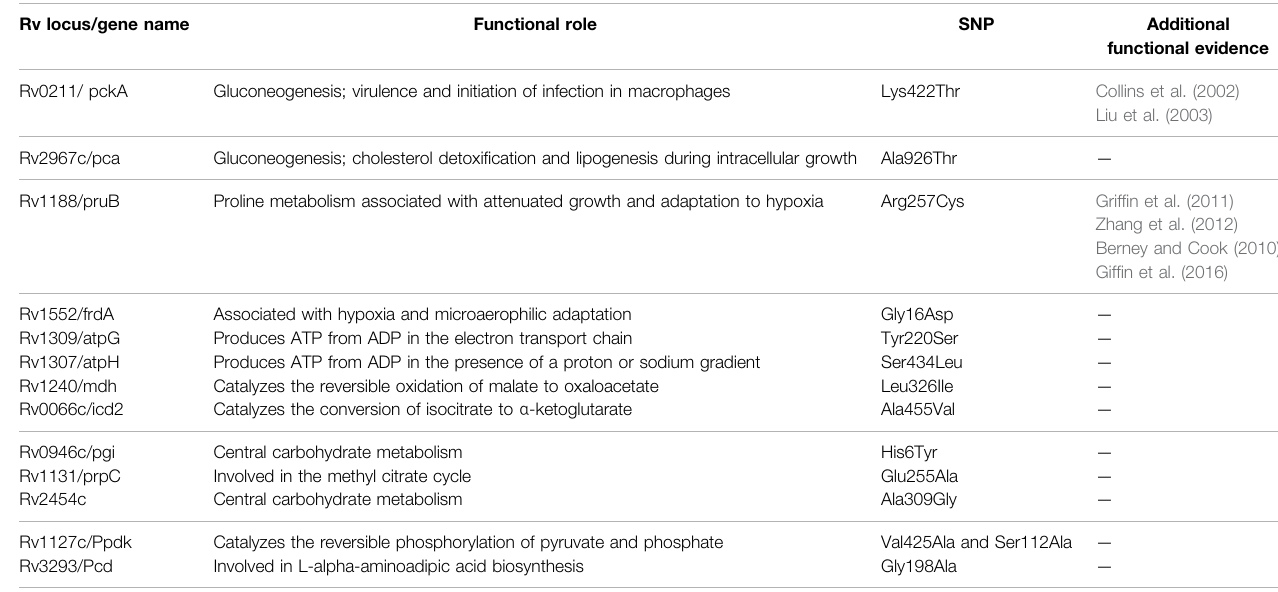
TABLE 5 | Functional mapping of core-cluster-speci fi c missense SNPs of L5 with literature support (Ofori-Anyinam et al., 2020), and functional role obtained from MycoBrowser (url: https://mycobrowser.ep fl